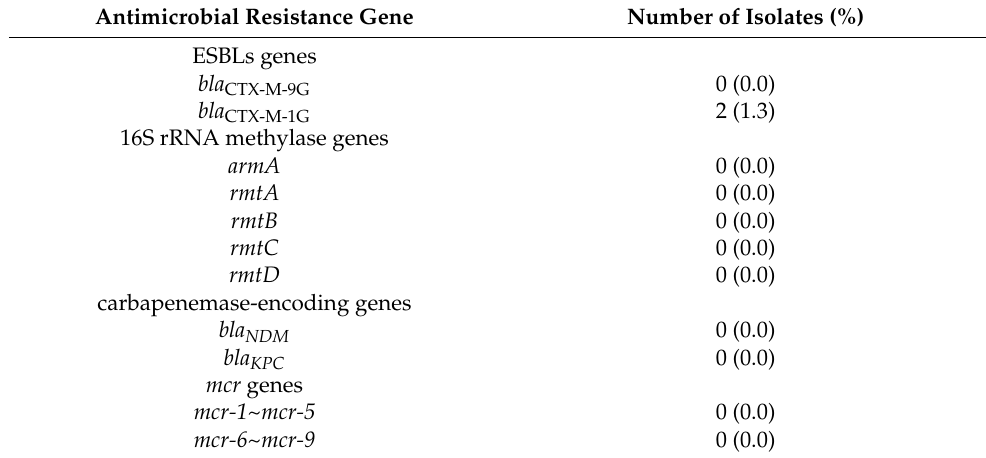
Table 3. Antimicrobial resistance genes in E. coli isolates from pigeon. Antimicrobial Resistance